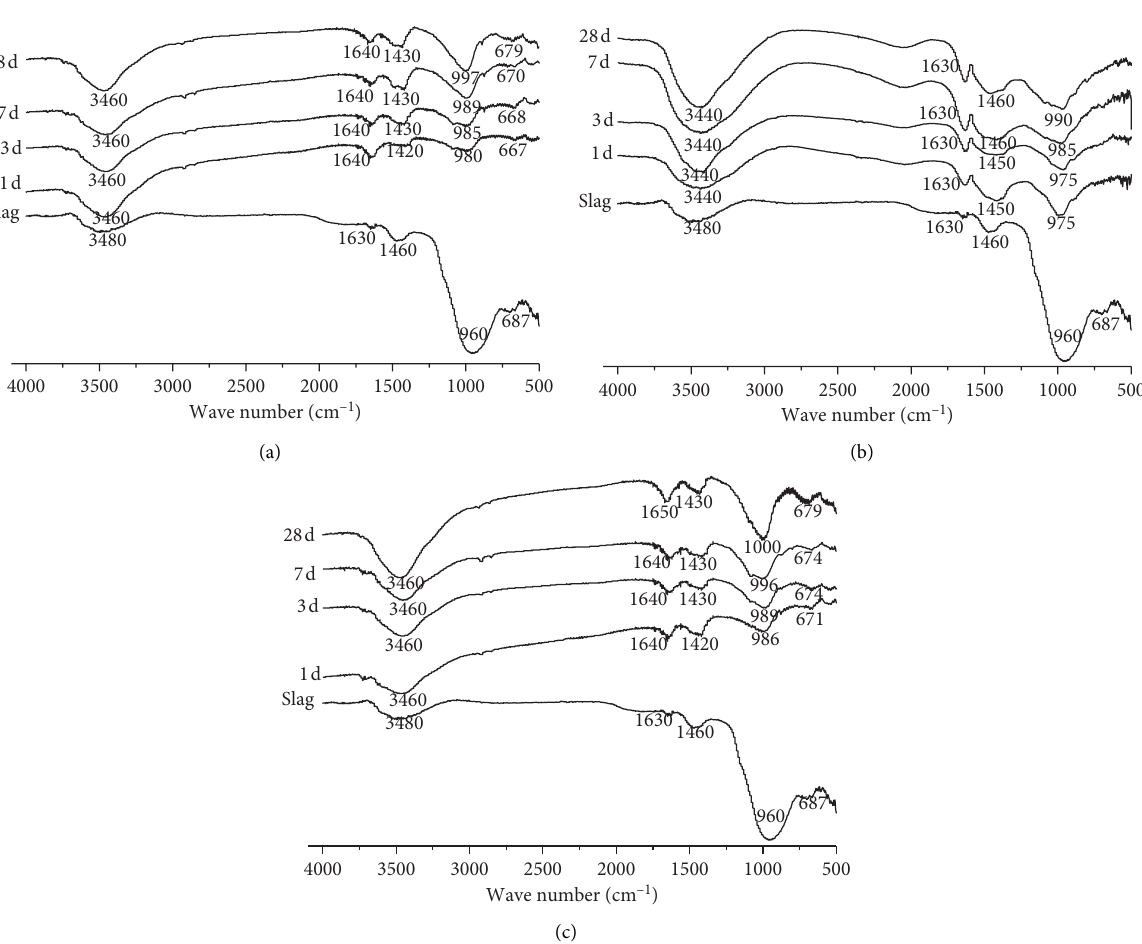
2 O equivalent was 0.107mol. (a) NS13-N2-J1. (b) NH8.52.